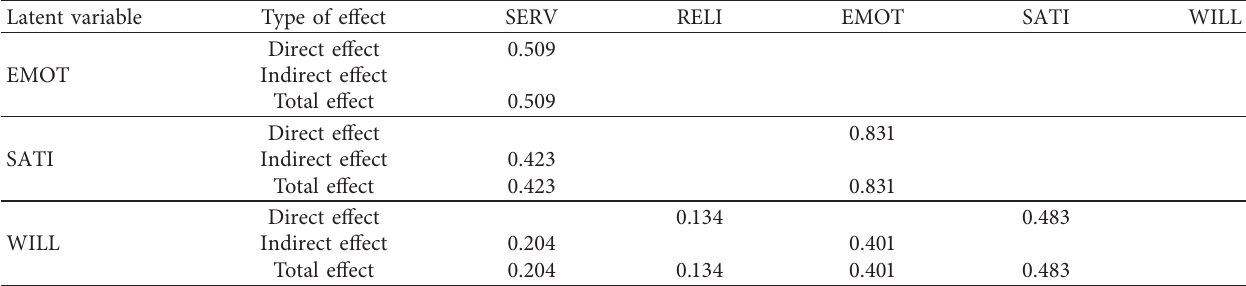
Table 6: Effects between latent variables.